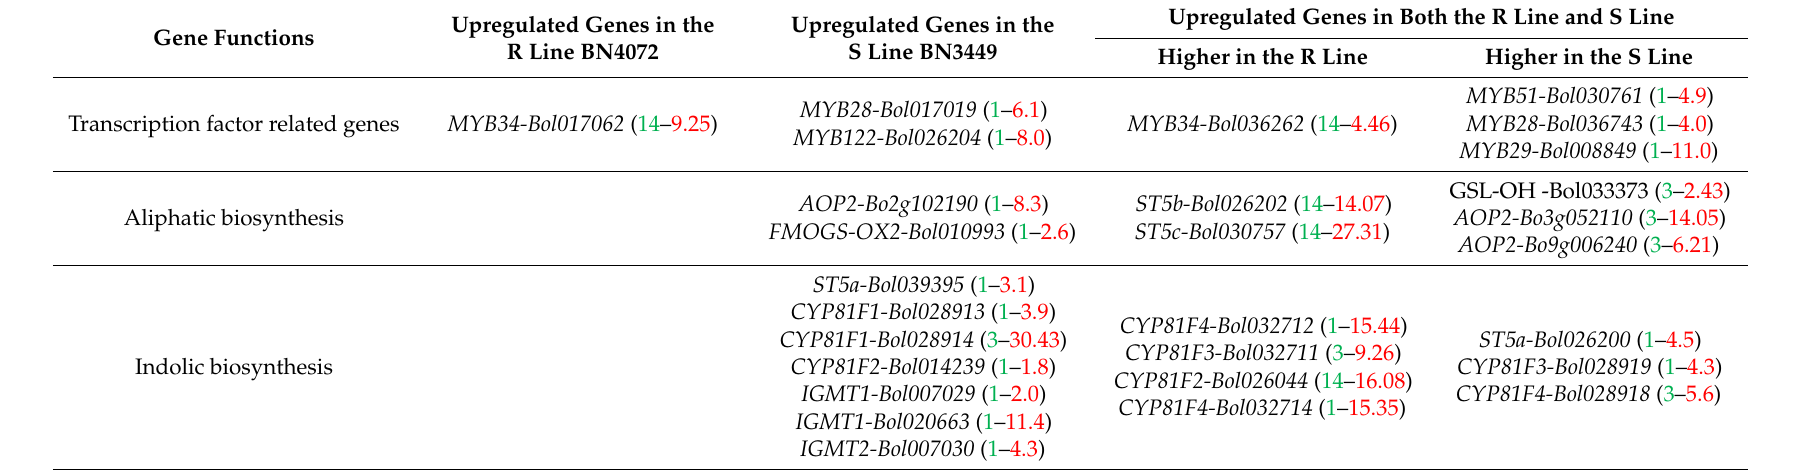
Table 2. Differential expression of glucosinolate biosynthesis pathway-related genes in the ringspot-resistant (R) line, BN4072, and the susceptible (S) line, BN3449, of cabbage. Green and red color indicate days at which genes are expressed (DAI) and fold-changes compared to the mock-treated plants,